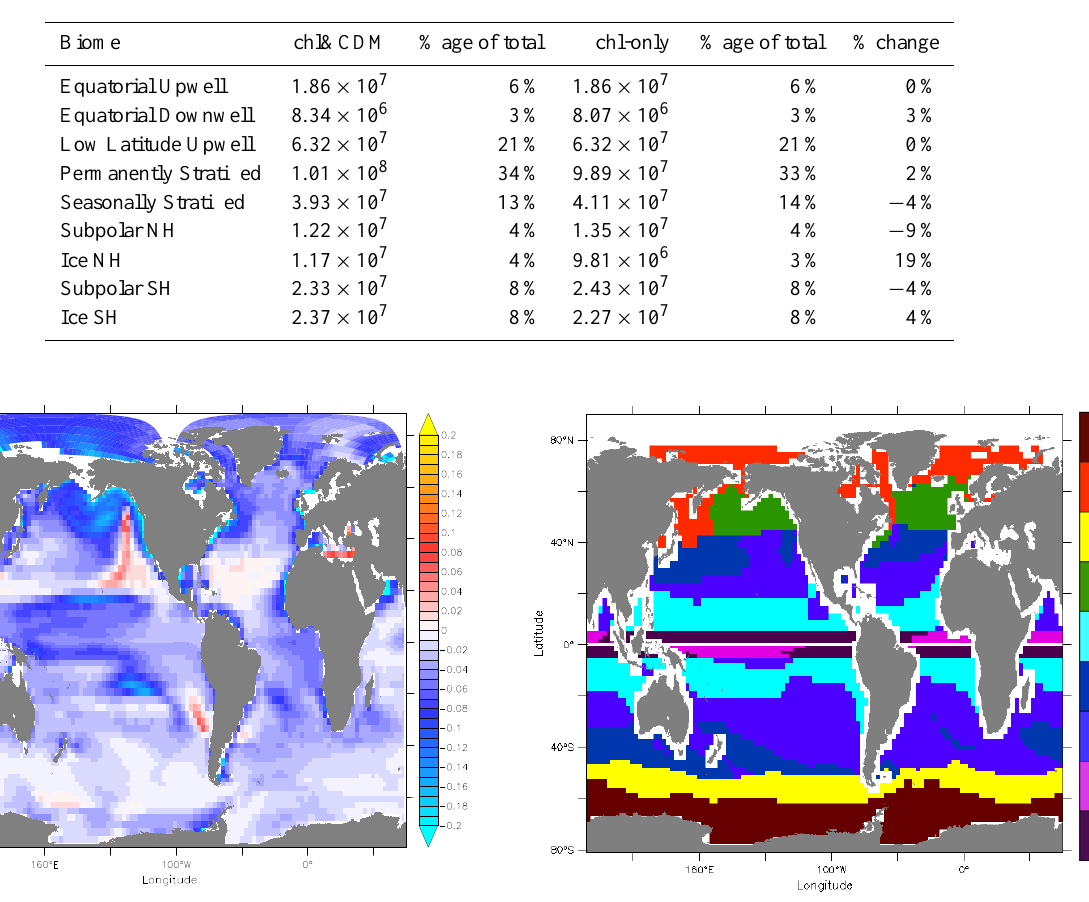
Figure 11. Difference in E bp , chl&CDM model run minus chl-only model run.